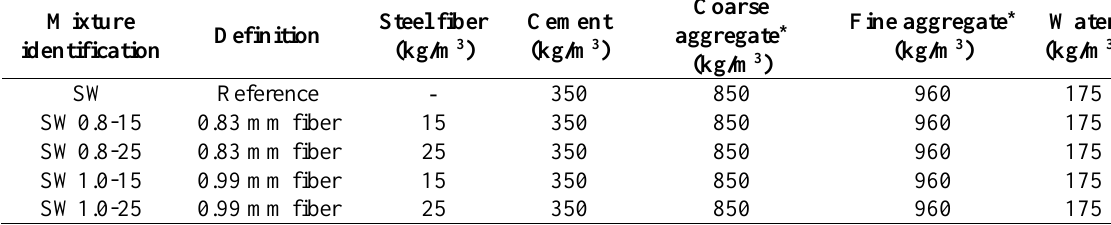
Table 3. Proportions of concrete mixture